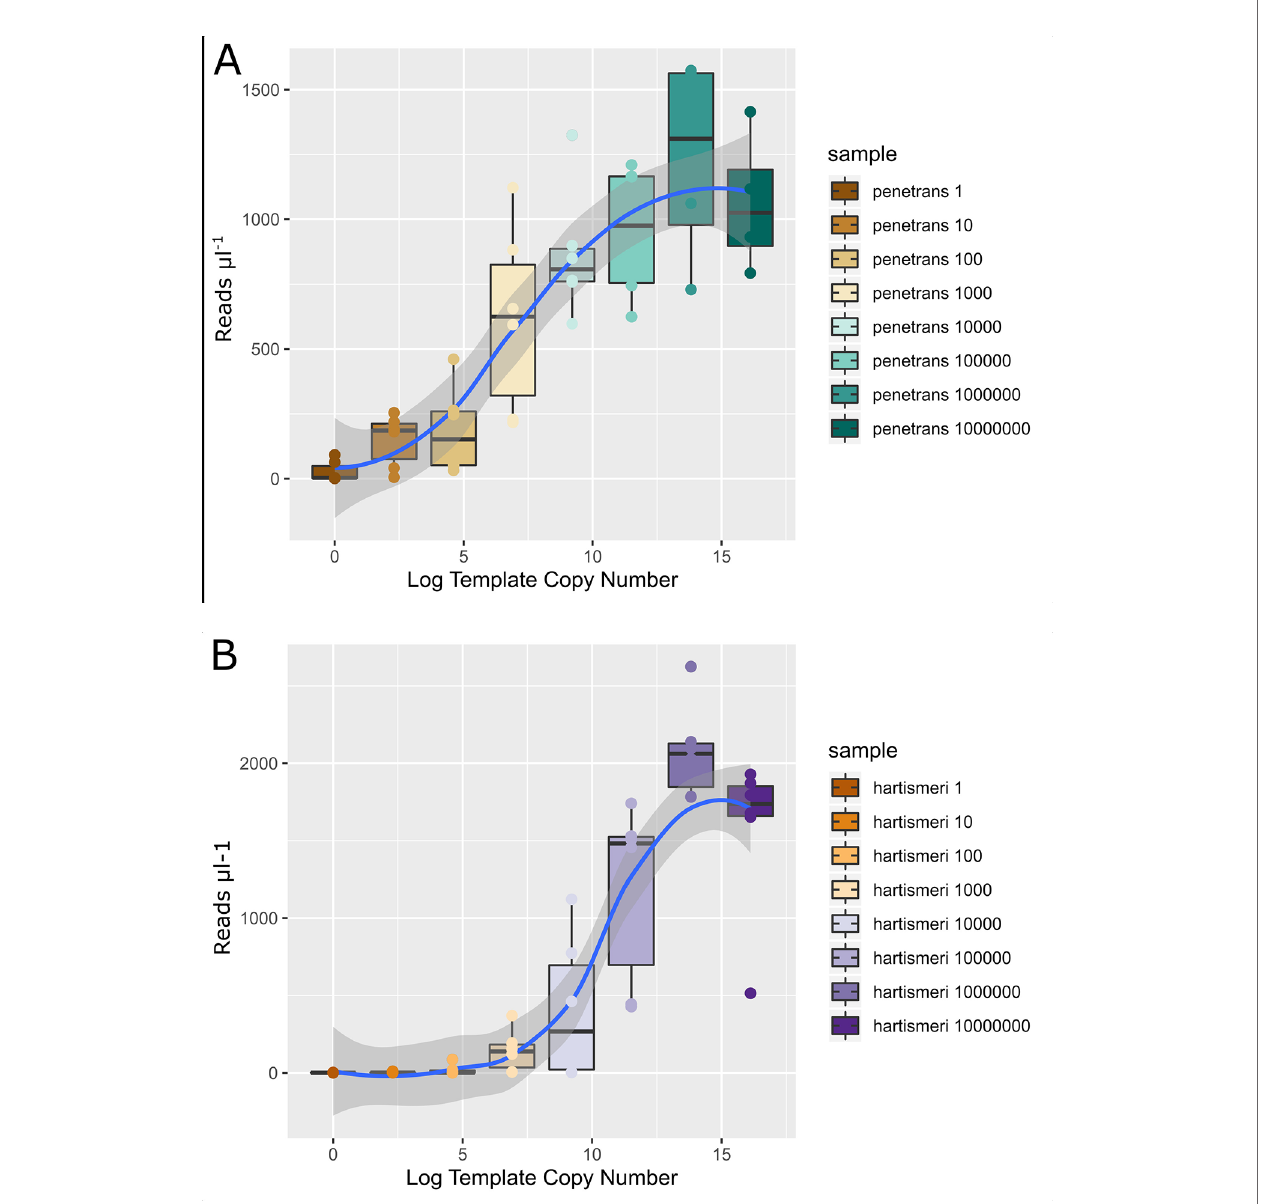
FIGURE 2 | Boxplots of Pasteuria penetrans (A) and P. hartismeri (B) 16S rRNA gene template copy number vs the merged paired read copy number ul − 1 of product added to the fi nal sequencing pool. Spearman's rank correlation is given as Rho and p. Loess curve of best fi t is given as the blue trend line with dark grey shading representing uncertainty in this fi t with a 95% con fi dence interval. Template copy number, representing the number of plasmids in each PCR reaction carrying the target gene, was log transformed as each input copy number was an order of magnitude greater or less than the next smallest or